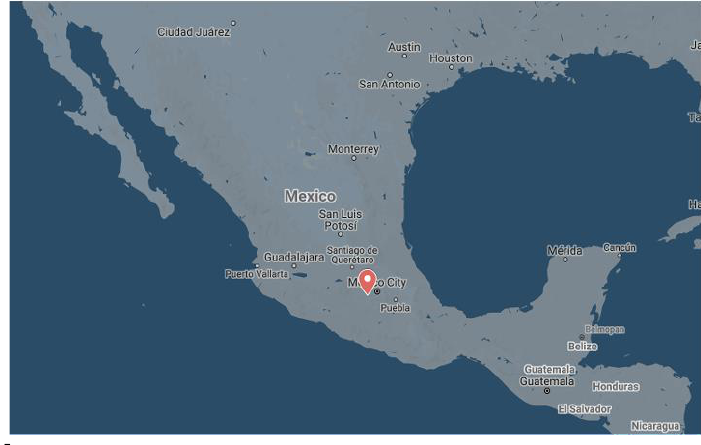
Figure 2. The city of Toluca in Mexico's central highlands